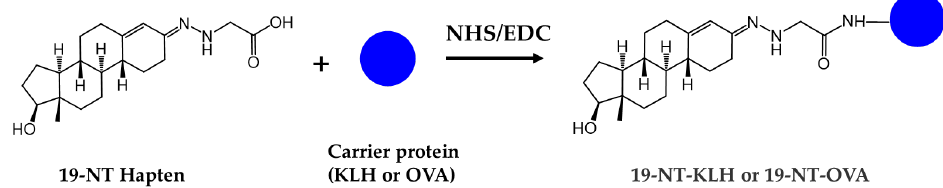
Figure 1. Structures of the conjugates of hapten 19-NT with carrier protein. 19-NT hapten, EDC (1-(3-Dimethylaminopropyl)-3-ethylcarbodiimide hydrochloride) and NHS (N-Hydroxy succinimide) were dissolved in 0.5 mL DMF(N,N-Dimethylformamide) (hapten: EDC: HNS = 1:1.5:1.5, molar ratio) and stirred in darkness for 4 h. Then OVA or KLH was dissolve in CB (Carbonate Buffer, pH 9.6) to 10 mg/mL final concentration and added to hapten-EDC/NHS dropwise (hapten: OVA/KLH = 30:1, molar ratio). The mixture was stirred in darkness overnight and then dialyzed in PBS to remove the unbinding hapten